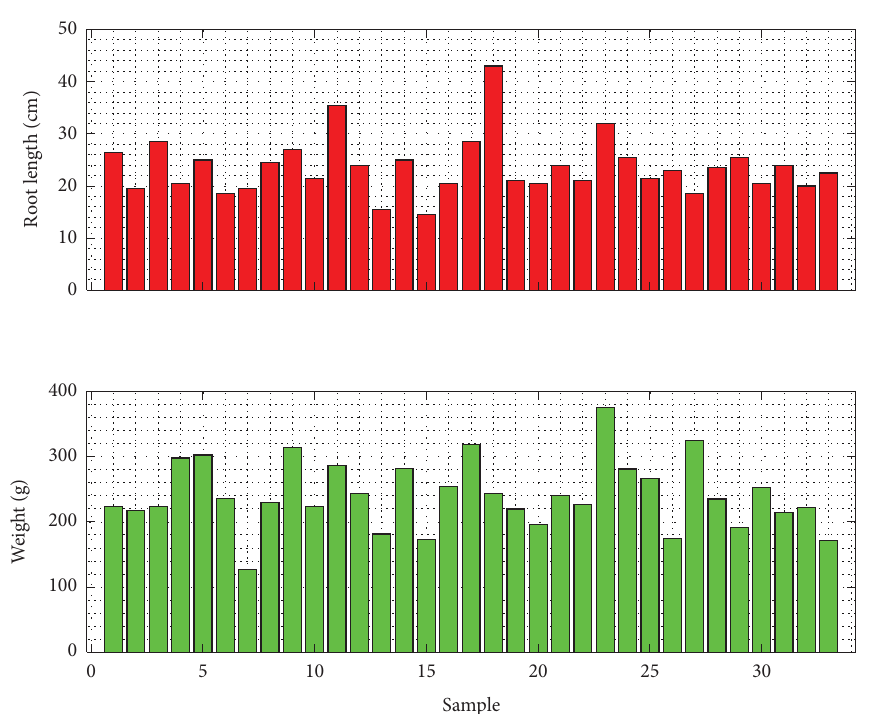
Figure 13: Te weight and root length of pagoda